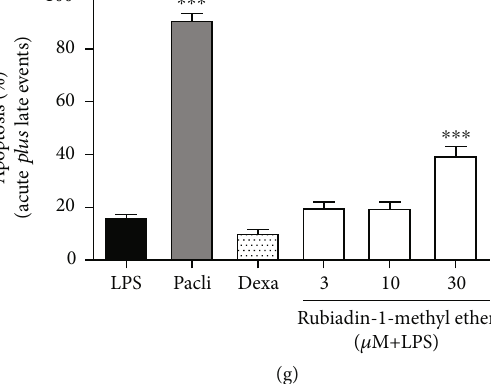
Figure 4: Flow cytometry dot plots representing the e ff ect of Rubiadin-1-methyl ether on RAW 264.7 macrophage apoptosis (acute plus late events). LPS: cells stimulated with LPS (1 μ g/mL) (a); Paclitaxel: cells pretreated with Paclitaxel at 30 μ M before LPS administration (b); Dexa: cells pretreated with Dexamethasone (7 μ M) 30min before LPS administration (c); and Rub: cells pretreated with Rubiadin-1-methyl ether at 3 μ M (d), 10 μ M (e), and 30 μ M (f). Results presented at graphic mode (g) and expressed as the mean ± S : D : ; n = 3 ; ∗∗∗ P < 0 : 001 compared with the LPS